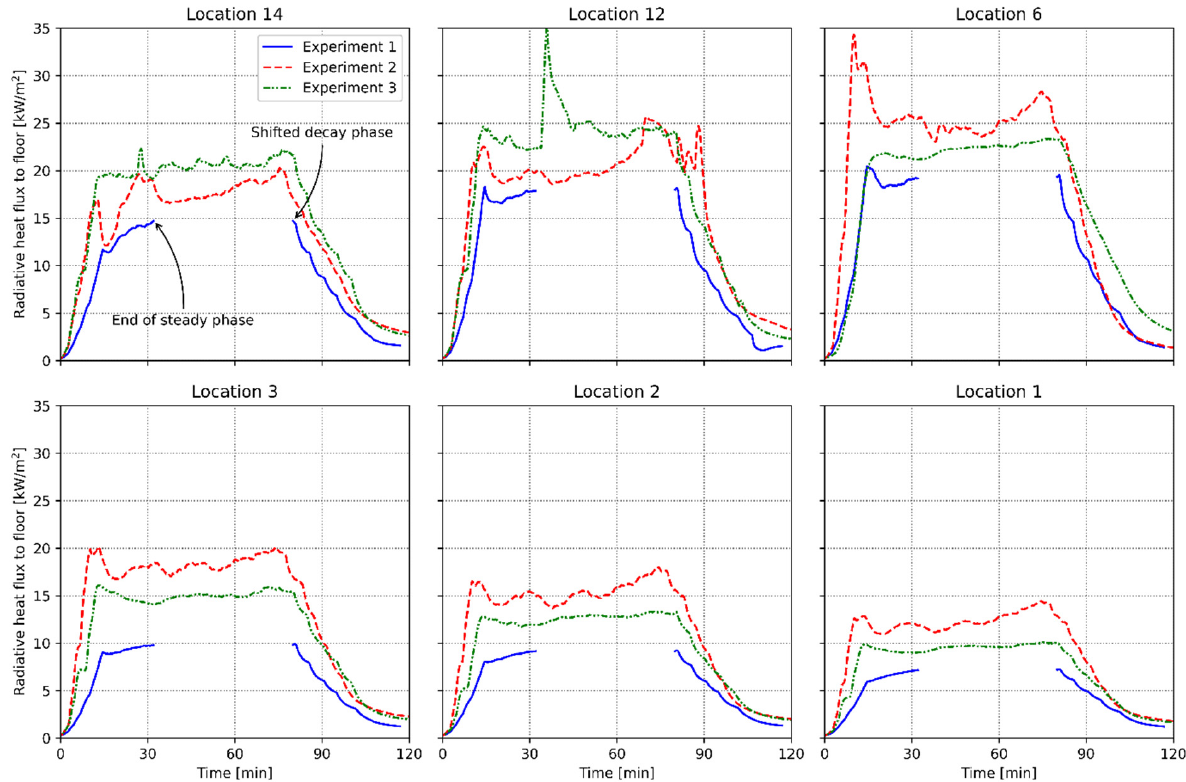
Figure 16. Radiative heat flux to floor estimated from PT measurements in Experiments 2 and 3.